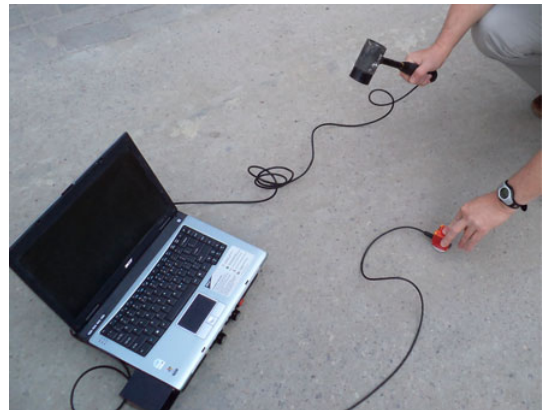
Fig. 9. Testing by means of non-destructive impulse re- sponse technique